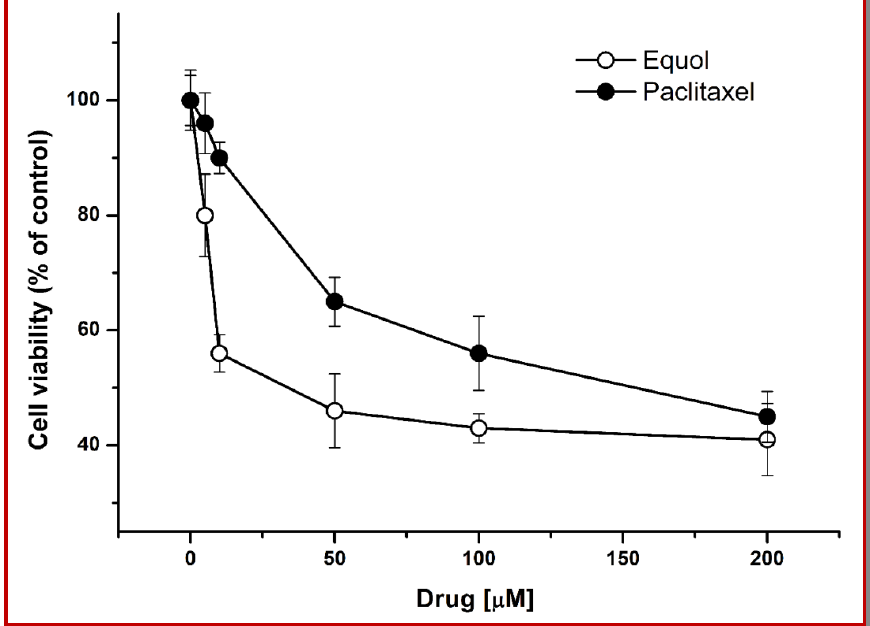
Figure 1 : MTT assay